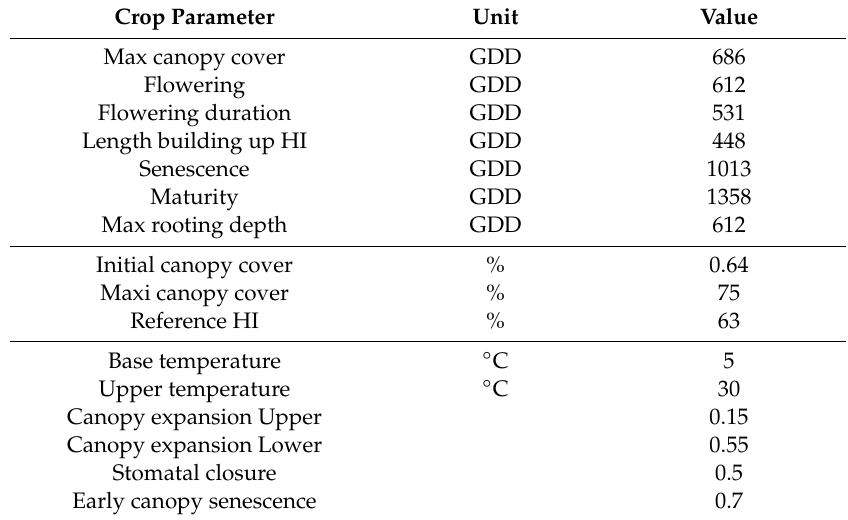
Table 3. Crop and water balance variables (Tr: Crop transpiration, E: Soil evaporation, ETp: Potential evapotranspiration, IWR: Irrigation water requirement, WP ET : Evapotranspiration water productivity, WP IWR : Irrigation water requirement water productivity).